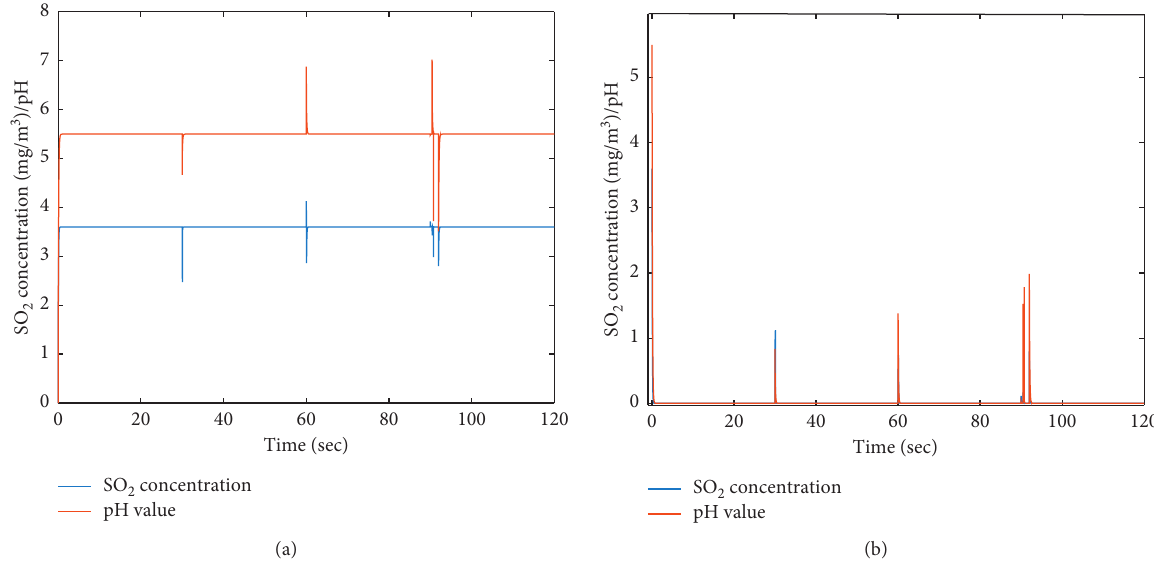
Figure 11: Control response of Case 2: (a) system outputs; (b) absolute value of the control